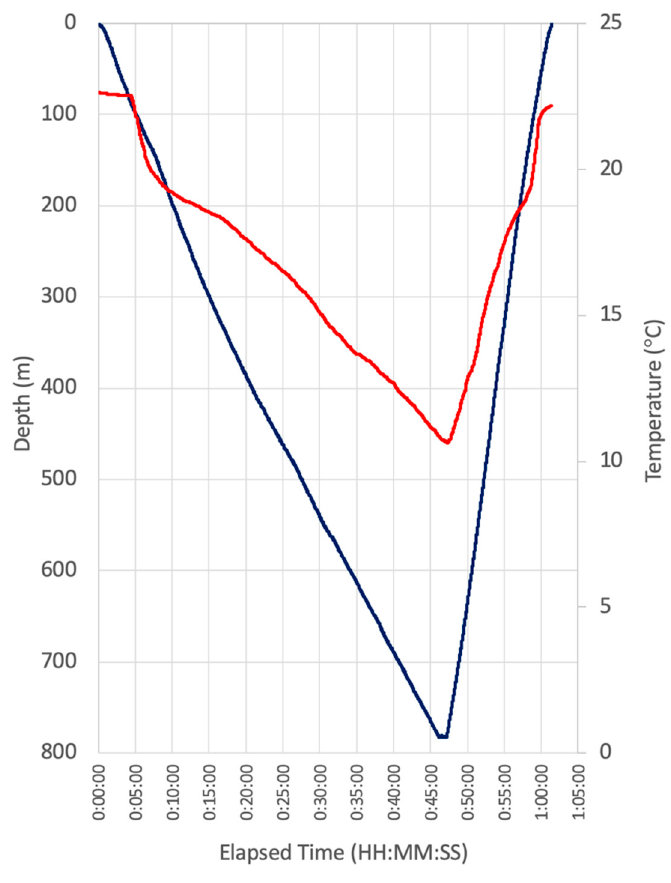
Figure 4. DPS depth and temperature profile from deepwater FOReelS deployment in Bermuda. See Supplementary Figure 1 for additional data of payload deployment behavior.